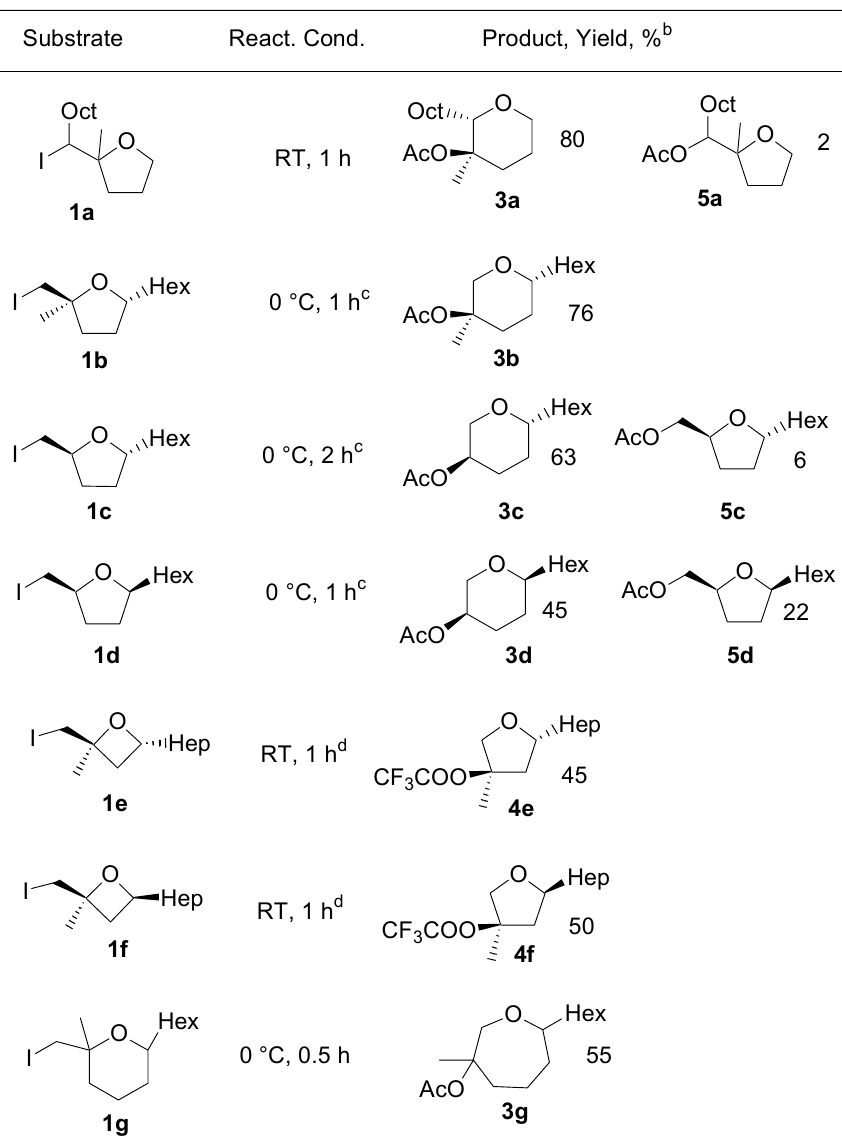
Table 2. Acyloxy ring-enlargement of cyclic ethers by DIT and BTI